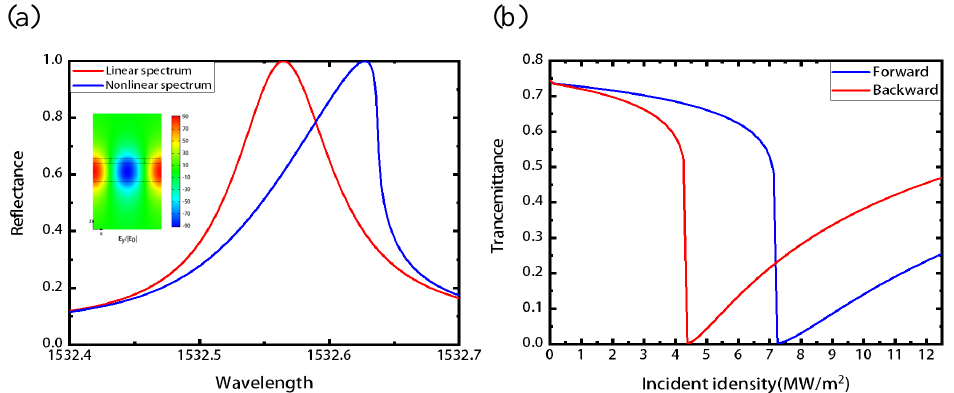
Figure 4. The non-linear and non-reciprocal propagation of the resonant Sb 2 S 3 -LN metasurface caused by Kerr effect. ( a ) The reflection spectrum of the Sb 2 S 3 -LN metasurface with incident intensity of 5.000 MW/m 2 . Red and blue curves represent linear and nonlinear spectra, respectively. Inset is electric field enhancement of the Sb 2 S 3 -LN metasurface with grating parameters of f = 0.5 and η = 0.2. ( b ) The non-reciprocal curve with the wavelength fixed at 1532.654 nm. The backward transmission is 0 with incident intensity of 4.375 MW/m 2 , while the forward is 0.67 with the same incident